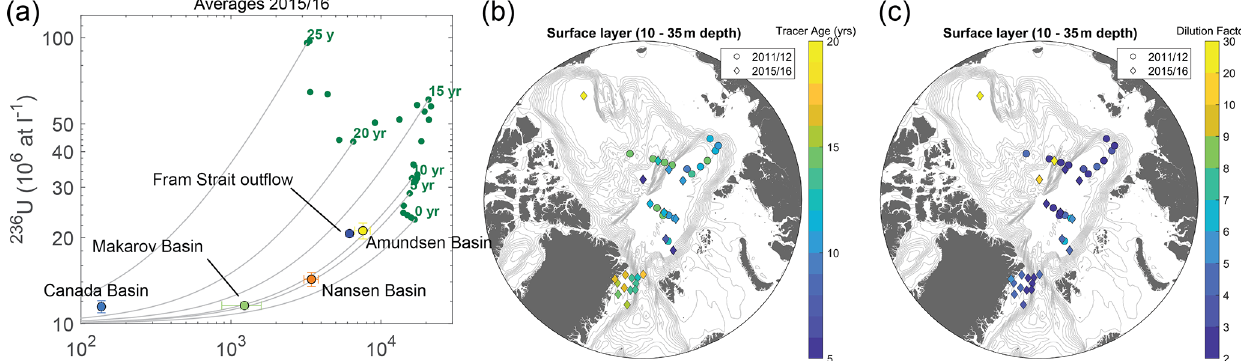
Figure 4. (a) Tracer age curves in the binary mixing model ( 236 U vs. 129 I) for the surface layer input function (green dots). Tracer ages (based on a collection year of 2015) are depicted in bold numbers. Samples from the surface layer from 2015 and 2016 were sorted by basin (see Table S1) and averaged; the average values and corresponding standard deviations are plotted on top of the mixing curves. Note the log–log scale. (b) Tracer ages and (c) dilution factors determined from the binary mixing model for individual stations in the surface